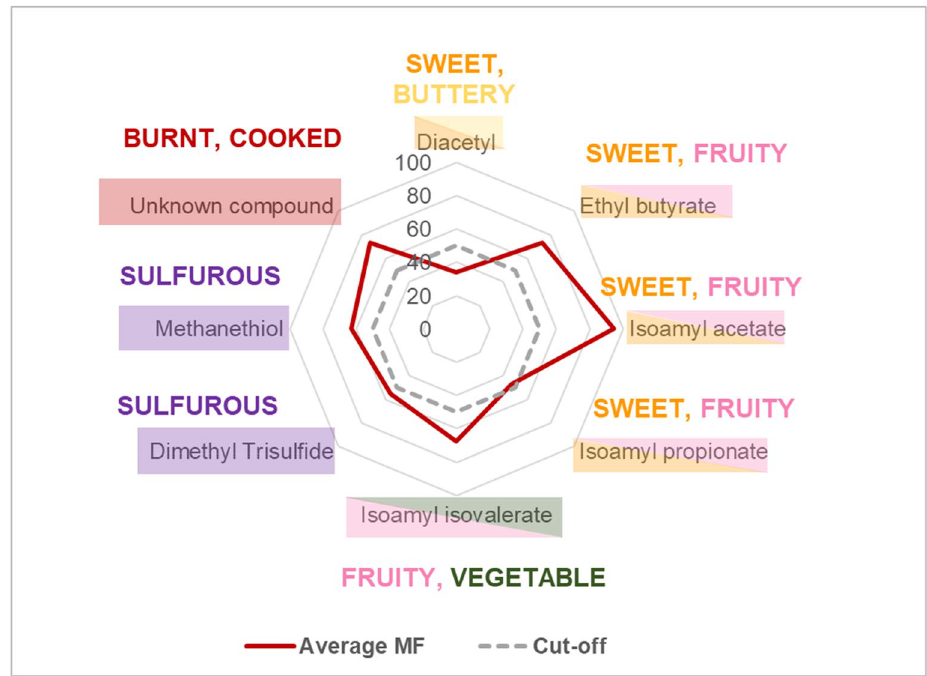
Figure 2. Aroma active compounds detected by all participants (n = 12) during the GC-O-MS analysis. Score shows average MF value for each